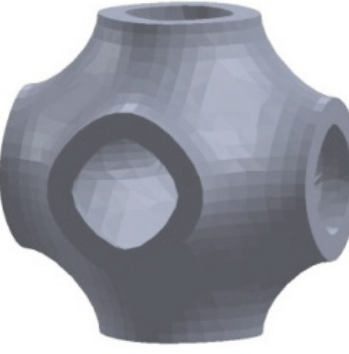
Figure 15: Solid P-cell ( 𝑘 = 0 , 𝑠 = 1